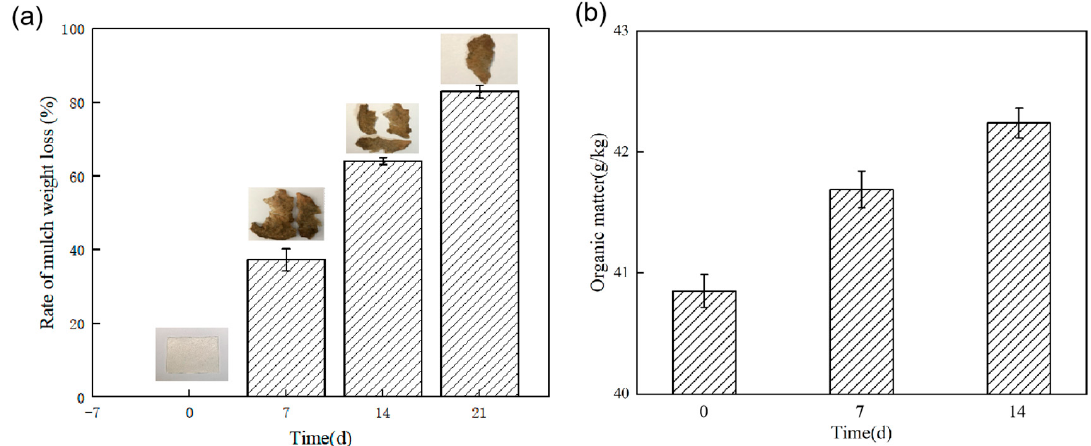
Figure 4. The rate of mulch weight loss under landfill experiment ( a ), changes in soil organic matter over time after application of liquid mulch ( b ).